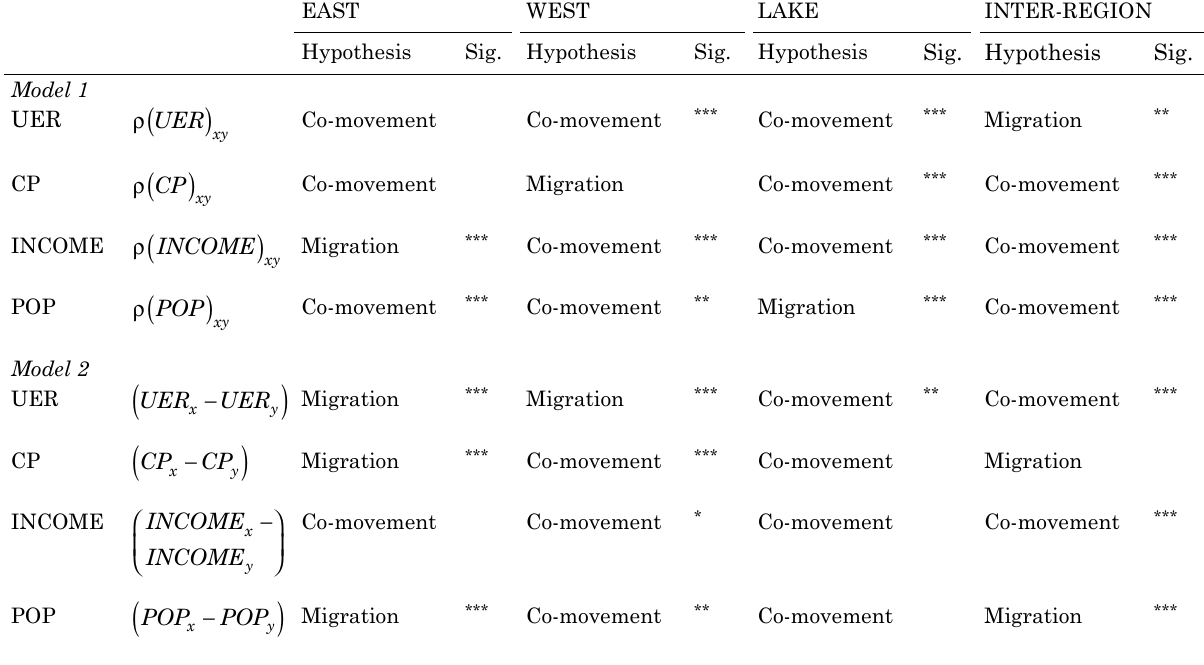
table 7. regression results of alternative